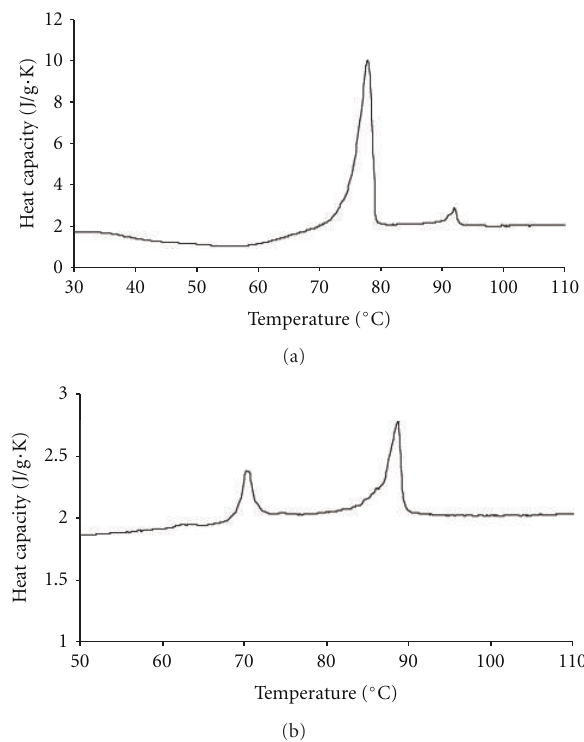
Figure 6: DSC thermograms of cholesteryl nonanoate at a rate of 10K · min − 1 , (a) heating, (b) cooling.